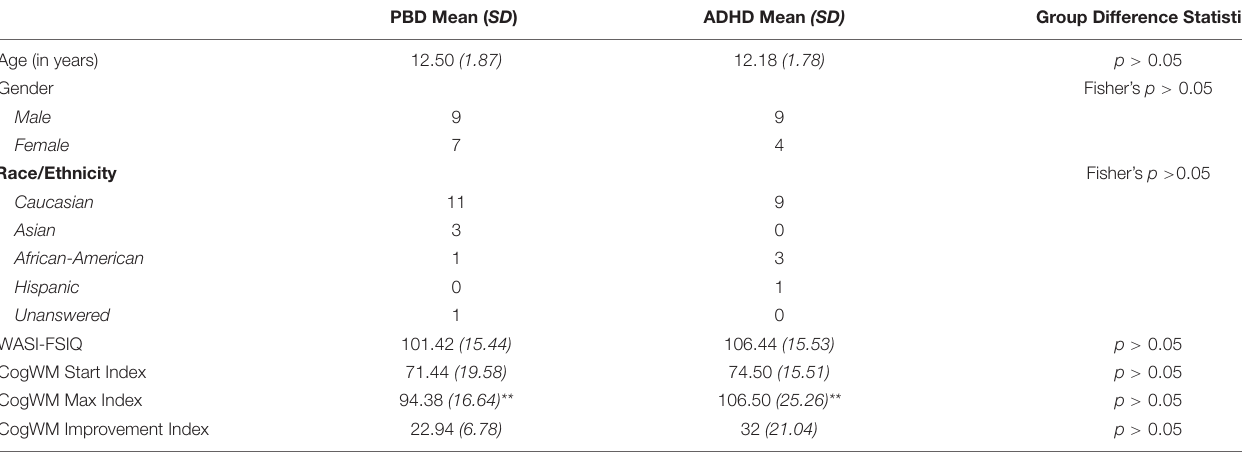
TABLE 1 | Demographic characteristics, WASI-FSIQ scores and Cogmed working memory index scores for patients with PBD and patients with ADHD.